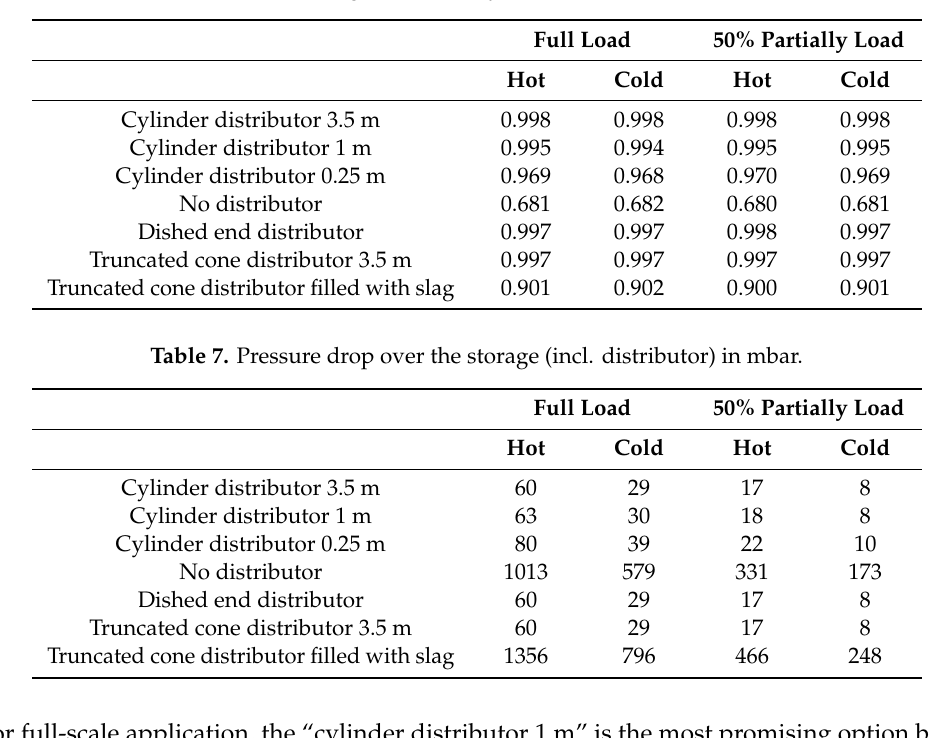
Table 6. Integral uniformity index γ int for all cases.